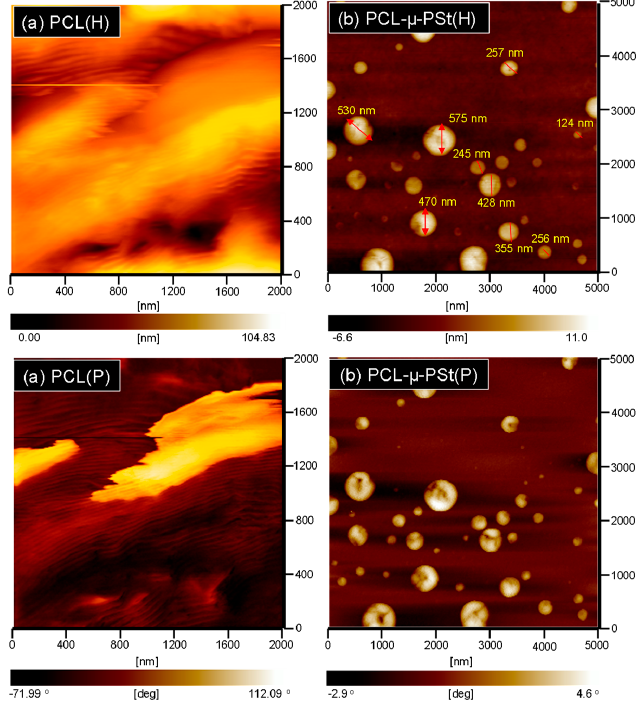
Figure 9. AFM images of ( a ) PCL and ( b ) PCL- μ -PSt (co)polymers (H: height and P: phase).